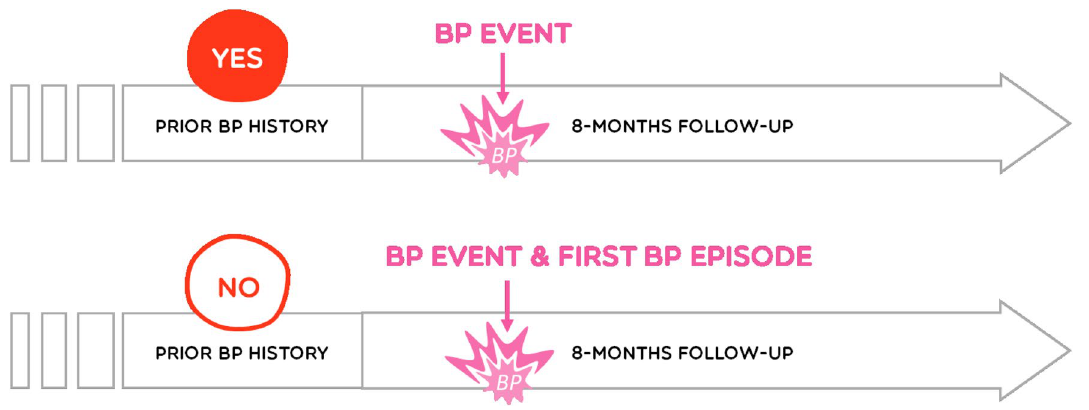
Figure 2. BP event and first BP